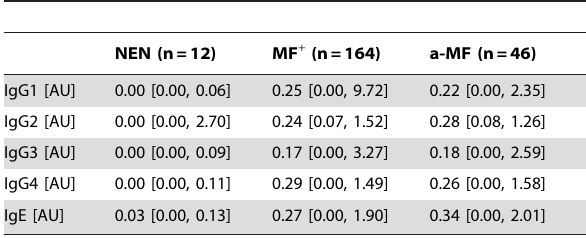
Table 1. O. volvulus -specific Ig levels of study participants shown as median and